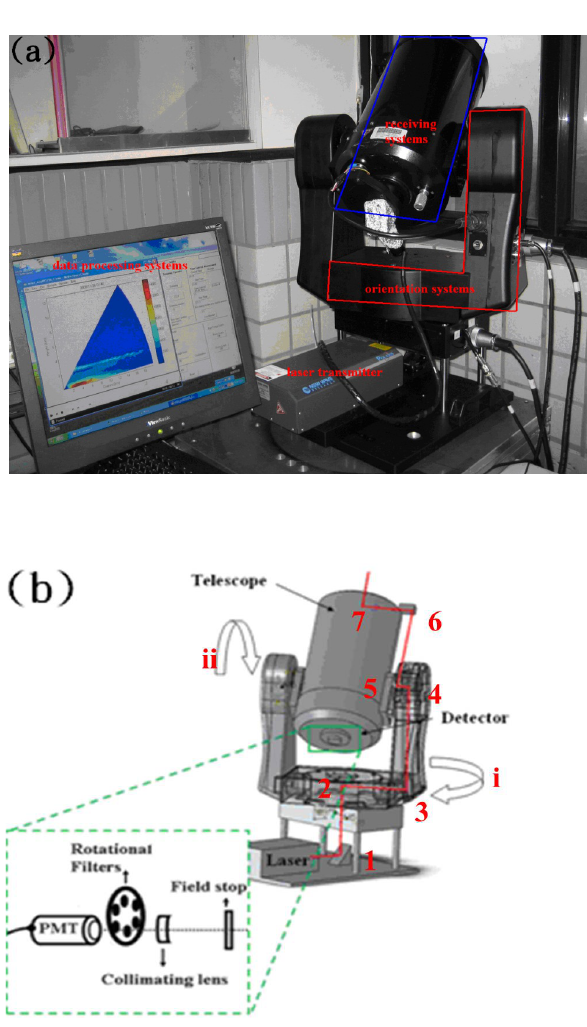
Figure 1. (a) Image and (b) prototype model of the 3-D scanning lidar system. In (b) , the arrows (i) and (ii) show the zenith and azimuth scanning direction. Red line shows the path of the trans- mitting laser beam. The numbers 1– 6 show the position of the re- flection mirror. The receiver section is shown in the enlarged box (green).